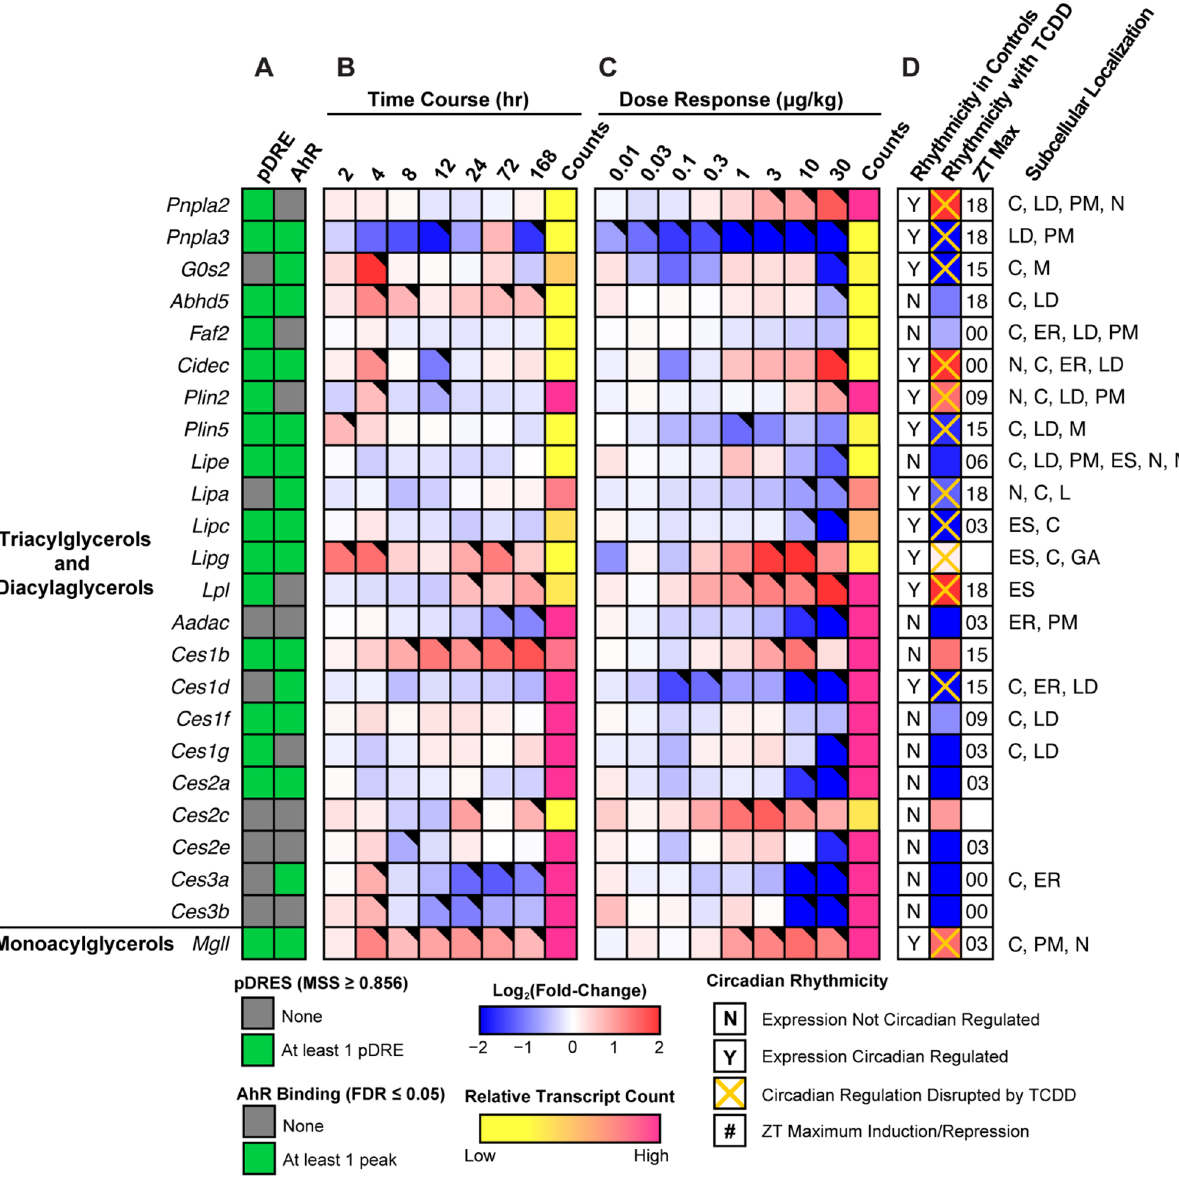
Slc27a2 (-5.9-fold), and Slc27a5 (-16.9-fold) following TCDD treatment (Fig. 3). In general, repression was dose- dependently observed within 168 h of a single bolus gavage of 30 µg/kg TCDD. Most ACS loci exhibited AHR